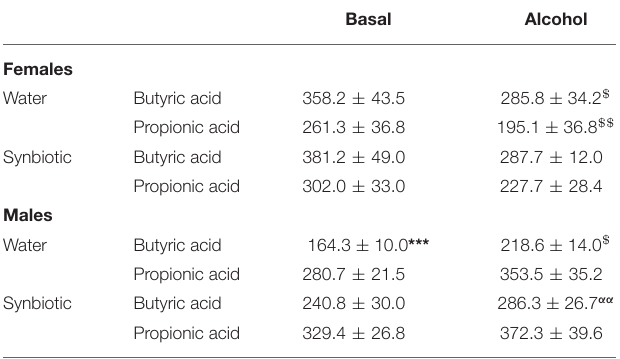
TABLE 1 | Fecal concentrations of butyric and propionic acids under basal conditions and following alcohol intake in female and male mice exposed to water or